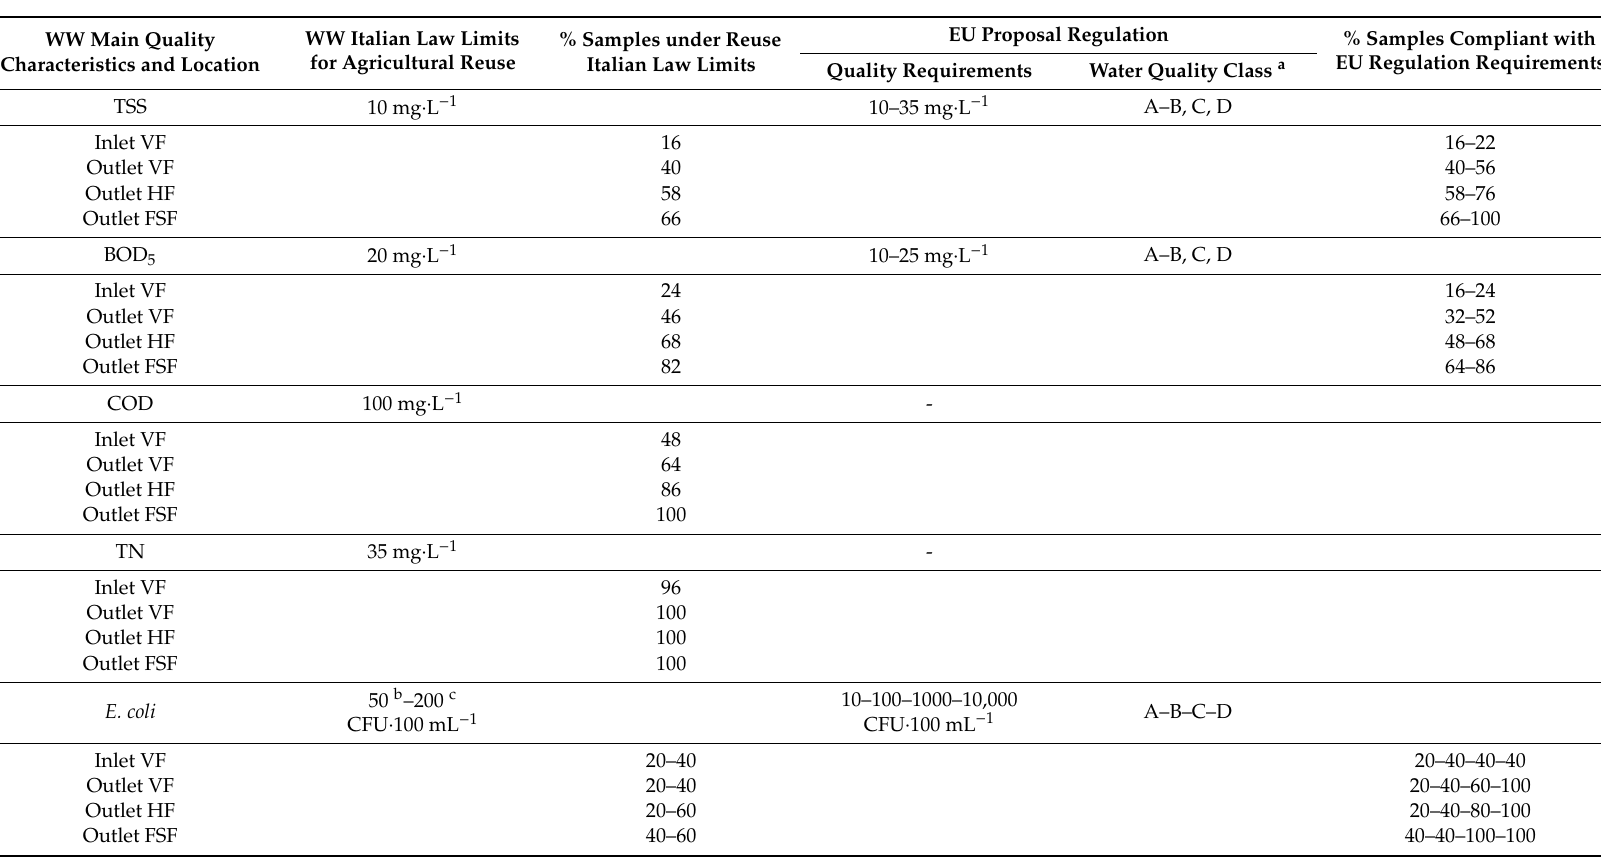
Table 2. Percentage, for each CW unit outlet, of wastewater samples below the Italian law limits and EU proposal regulation on minimum requirements for water